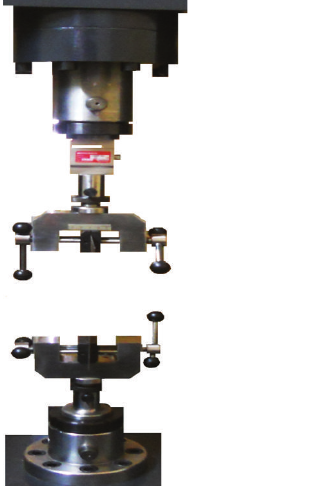
Figure 2: Schematic of universal testing machine. To measure the friction between the wire and bracket, a universal testing machine (SANTAM) (Sahand Company, Iran) was used. Straight line static traction test was carried out by this machine to simulate sliding of wire in the bracket. At one end of the machine there was an aluminum device that was attached to a 50 N load cell; this machine included two plates. The brackets were bonded to the lower stable plate. The wire was attached to the upper plate and then engaged in the bracket by elastomeric ligation; the wire was pulled out of the slot of the bracket with 50 N load cell at a rate 1 mm/min.